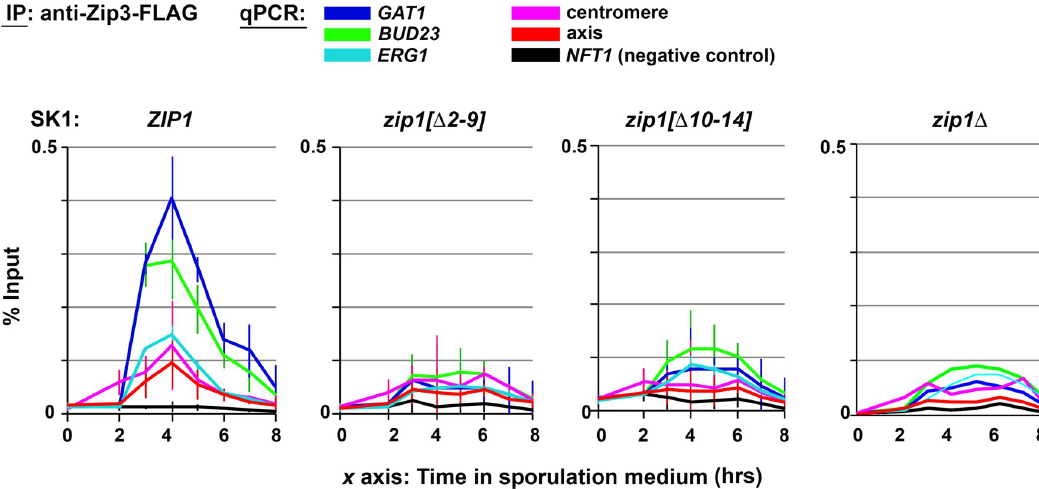
Fig 11. Residues 2–14 are required for Zip1’s capacity to recruit Zip3 to recombination initiation sites. Chromatin immunoprecipitation (ChIP) followed by quantitative PCR (qPCR) to monitor the association of Zip3-FLAG with three DSB sites ( GAT1 , BUD23 , ERG1 , dark blue, green and light blue lines, respectively) as well as to centromere and axis sites (magenta and red lines, respectively) in SK1 strains carrying ZIP1 (ORD9670), zip1[ Δ 2–9] (AM3946/VBD1872), zip1[ Δ 10–14] (AM3951/VBD1873), or zip1 Δ (ORD9689) alleles. x axes indicate number of hours after placement in sporulation medium. The relative abundance of indicated chromosomal sites detected by qPCR in Zip3-FLAG immunoprecipitates is expressed as a percentage of the abundance of each site detected in the input, prior to immunoprecipitation. Values are the average ± standard deviation from two independent experiments. A single experiment was performed in the case of the zip1 null strain. Data plotted is listed in S6